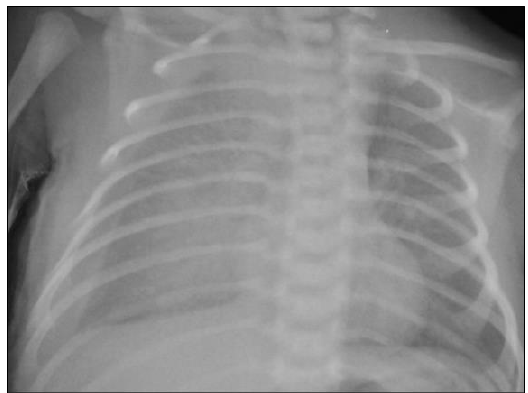
Figure 1. Chest x-ray demonstrating the presence of pleural effusion at 30 min of